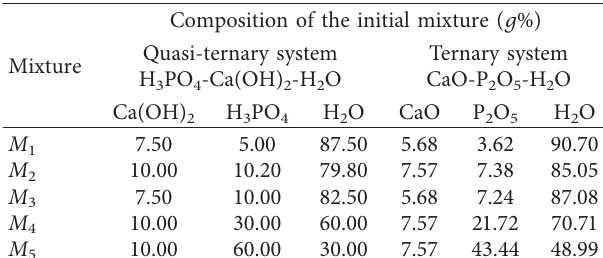
Figure 1: Solubility diagram of the Ca(OH) ° C [7]. ME, EF, and FJ are the solubility branches of 2 -H 3 PO 4 -H 2 O quasi-ternary system at 30 solids S 2, S 3, and S 4. M 1– M 5 represent the composition of experimental mixtures according to Table 2. Table 2: Compositions of studied